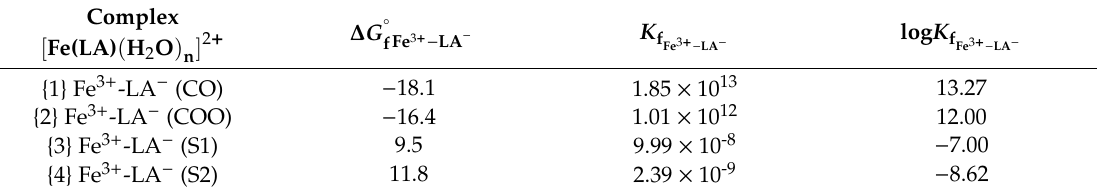
Table 1. Standard Gibbs free energy change ( ∆ G the chelation of Fe(III) with lipoic acid, LA − , (as per Equation (4)) in aqueous solution at 298.15 K.